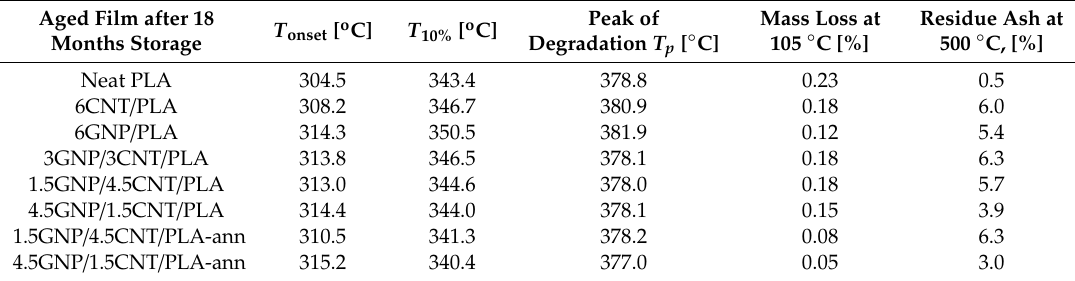
Figure 6. TGA thermograms of weight loss and the derivative versus temperature, comparing the aged bifiller films, 1.5GNP / 4.5CNT / PLA and 4.5GNP / 1.5CNT / PLA, before and after annealing. Arrows point to the corresponding Y-axis of each set of graphs. Table 2. Thermal stability ( T onset ) and degradation peak ( T p ) temperatures and mass loss of aged films at 6 wt.% filler. E ff ect of annealing on thermal characteristics of bifiller 下面还有 figure 7